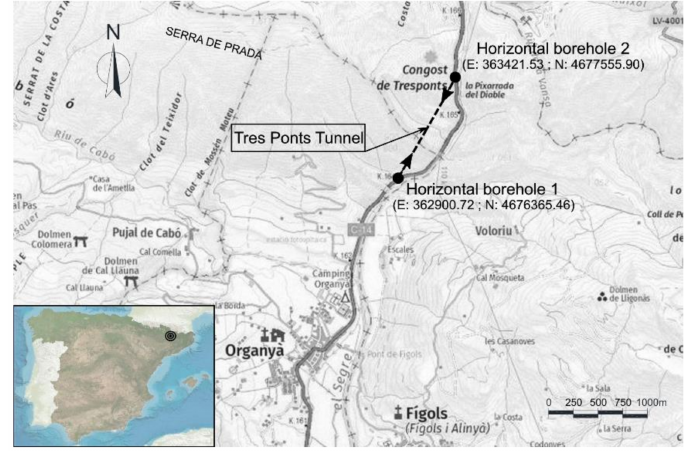
Figure 1. Location of the Tres Ponts Tunnel in the Congost de Tresponts area. Borehole coordinates are expressed in meters in the UTM 31N/ETRS 89 reference system. Image modified from Institut Cartogr à fic i Geol ò gic de Catalunya (www.icc.cat accessed on 25 February 2021).